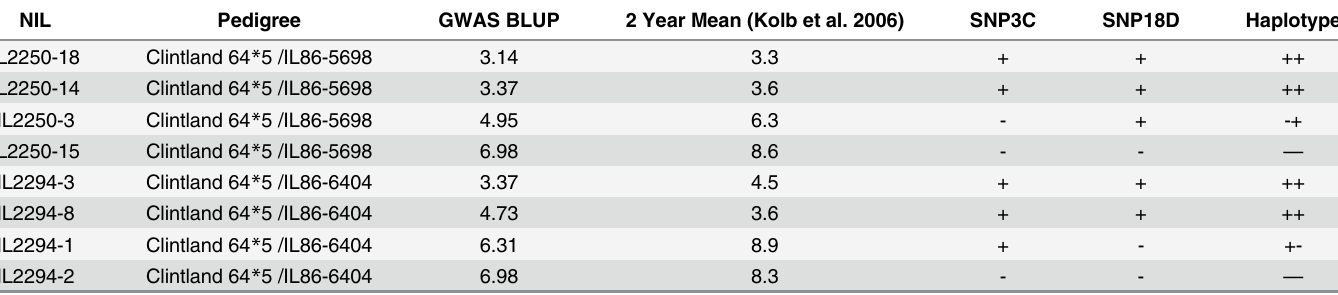
Table 4. Barley yellow dwarf virus haplotypes for SNP3C and SNP18D in two sets of near-isogenic lines from Kolb et al. 2006. NIL Pedigree GWAS BLUP 2 Year Mean (Kolb et al. 2006)